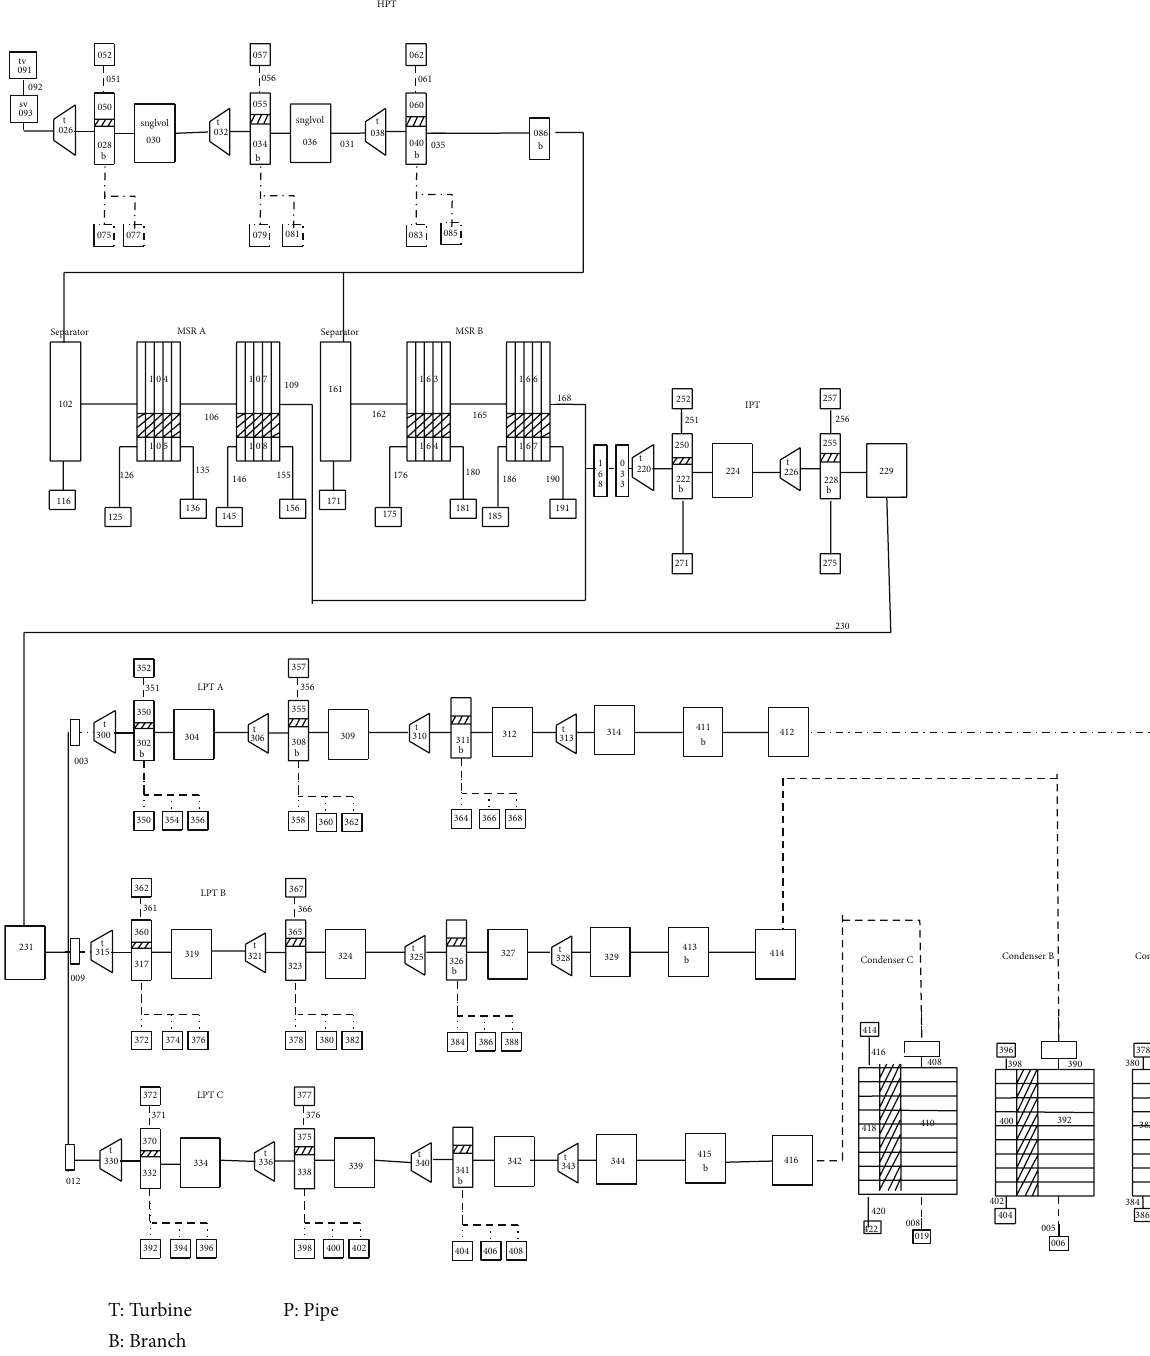
Figure 2: Nodal map of thermal-hydraulic system in conventional island (part